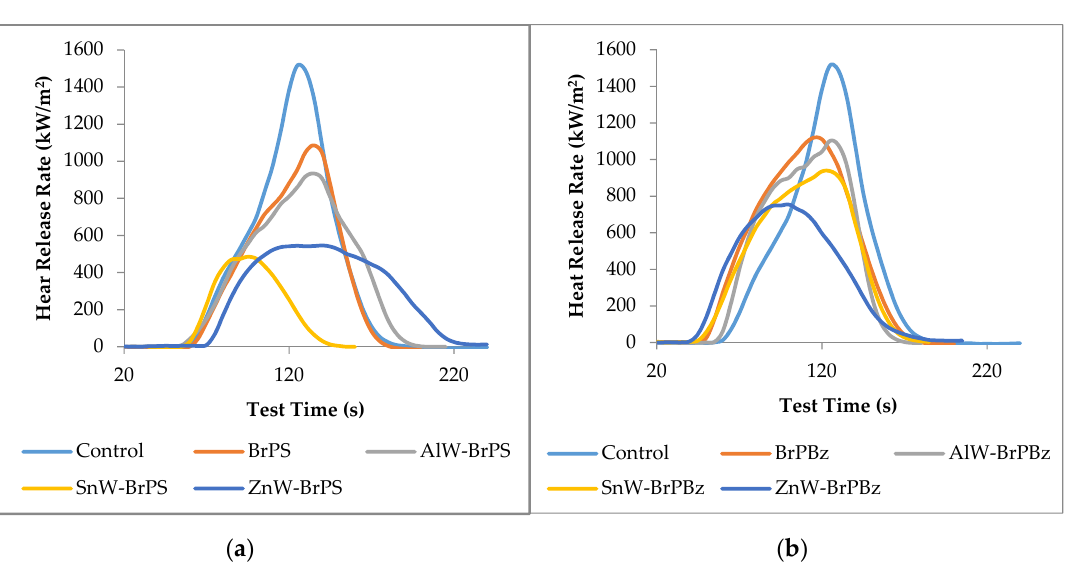
Figure 3. Cone calorimetry heat release rate curves for Table 1 samples. ( a ) formulations containing brominated polystyrene (BrPS) and ( b ) formulations containing poly(pentabromobenzyl acrylate) (BrPBz). AlW, SnW and ZnW = aluminium, tin (II) and zinc tungstates respectively.